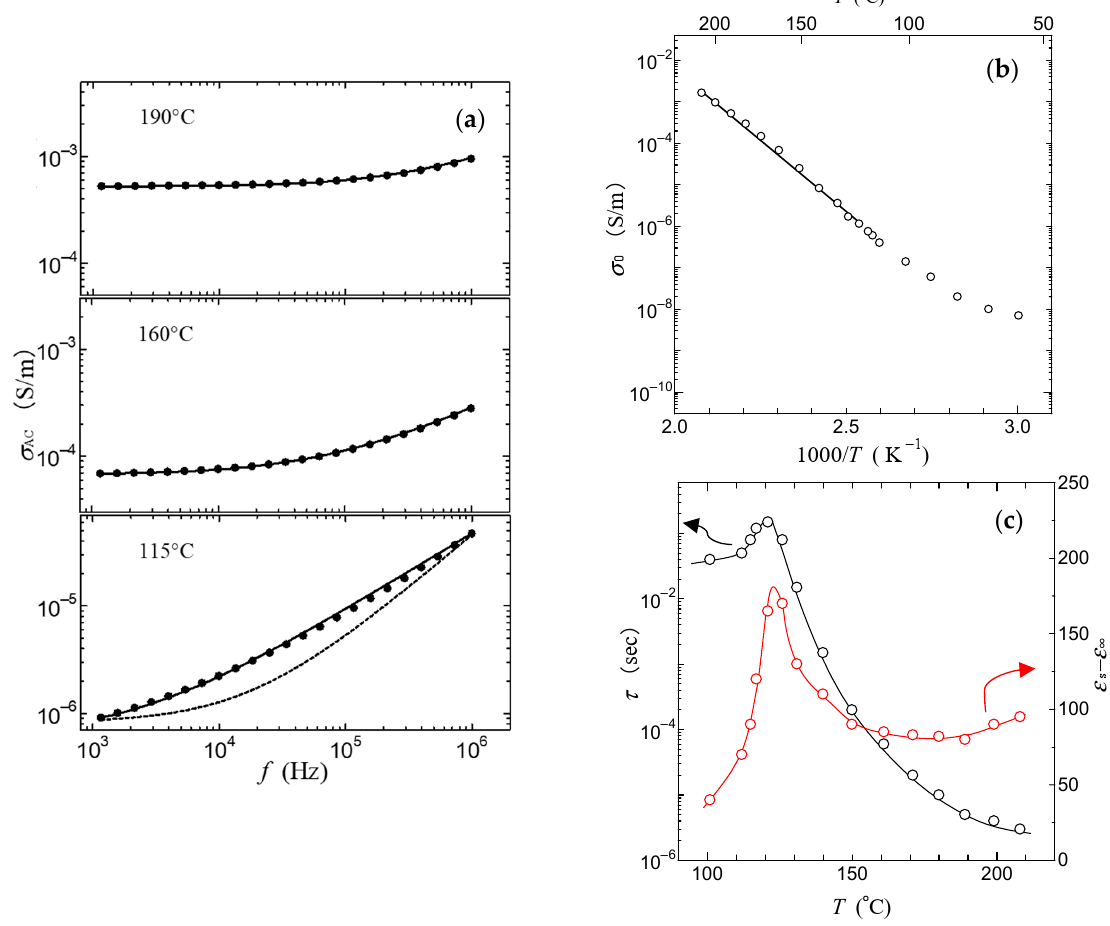
Figure 8. Impedance measurement in the imidazole–collagen composite film ( n = 2): ( a ) frequency dependence of σ AC , ( b ) temperature dependence of σ AC , ( c ) temperature dependence of τ and ε s - ε ∞ .